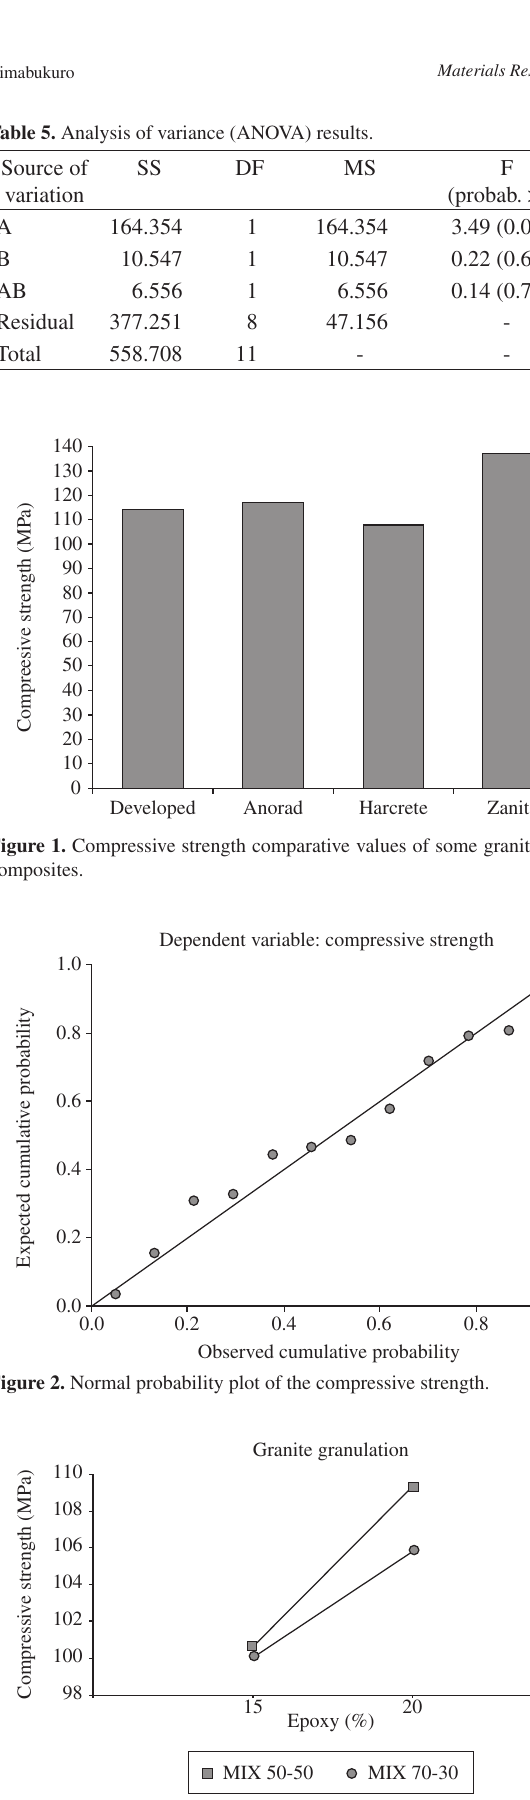
Figure 3. Mean effects of variables A and B and AB